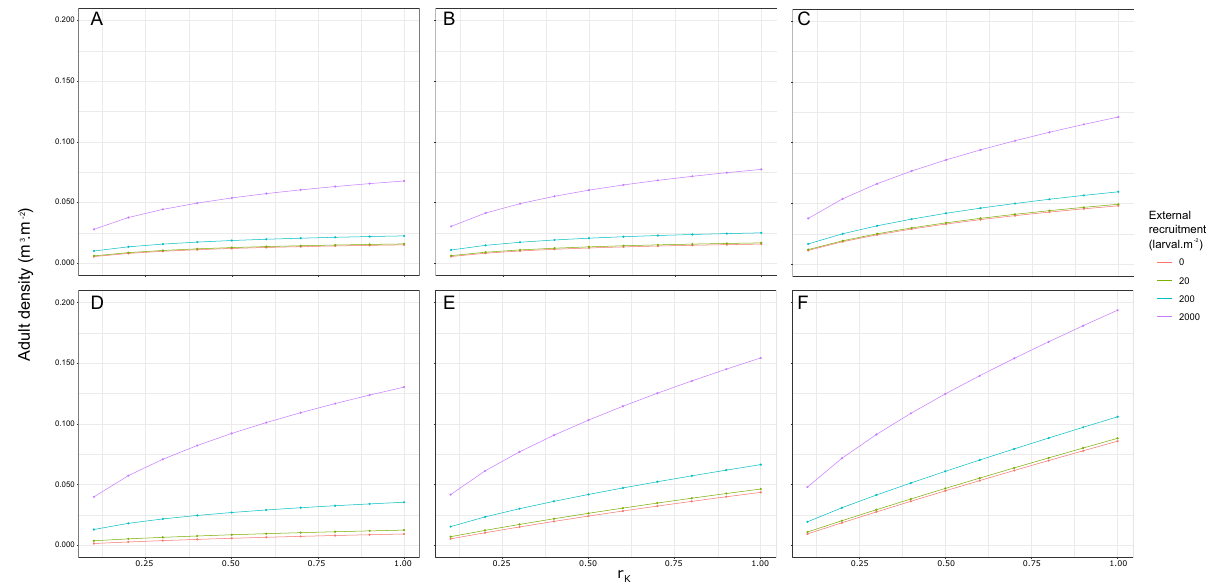
3 m − 2 ) at year 20 over r K , the carrying capacity 2 2 , green—R = 20 larvae m − , blue—R = 200